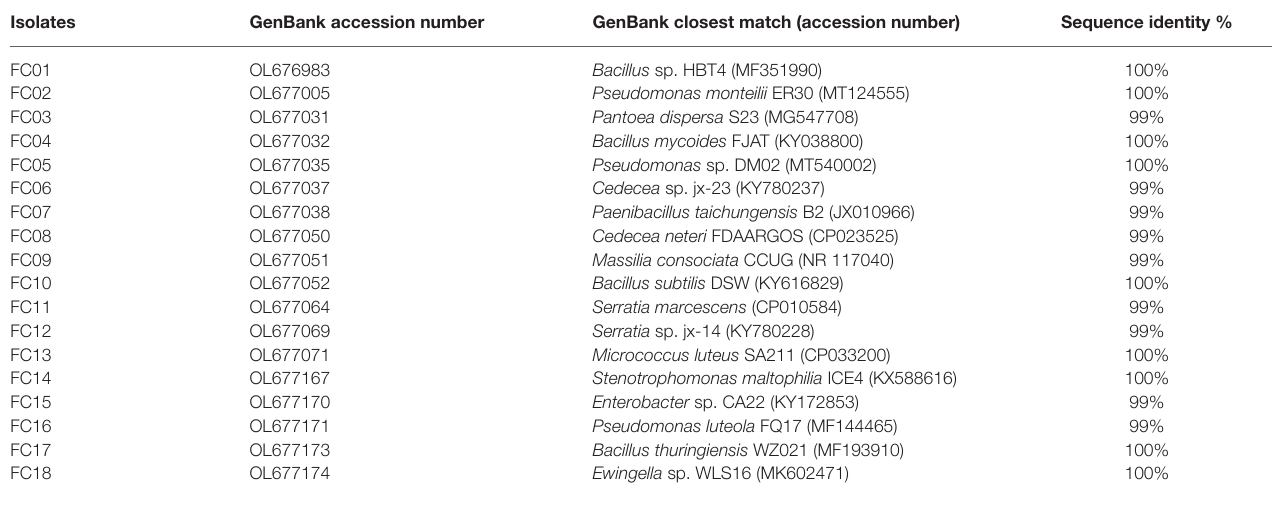
TABLE 2 | Identification of the isolates based on the 16S rRNA gene sequence.